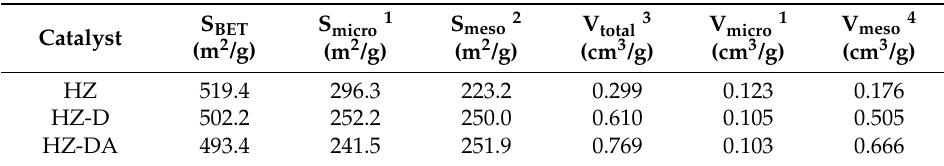
Table 1. Porosities of tested